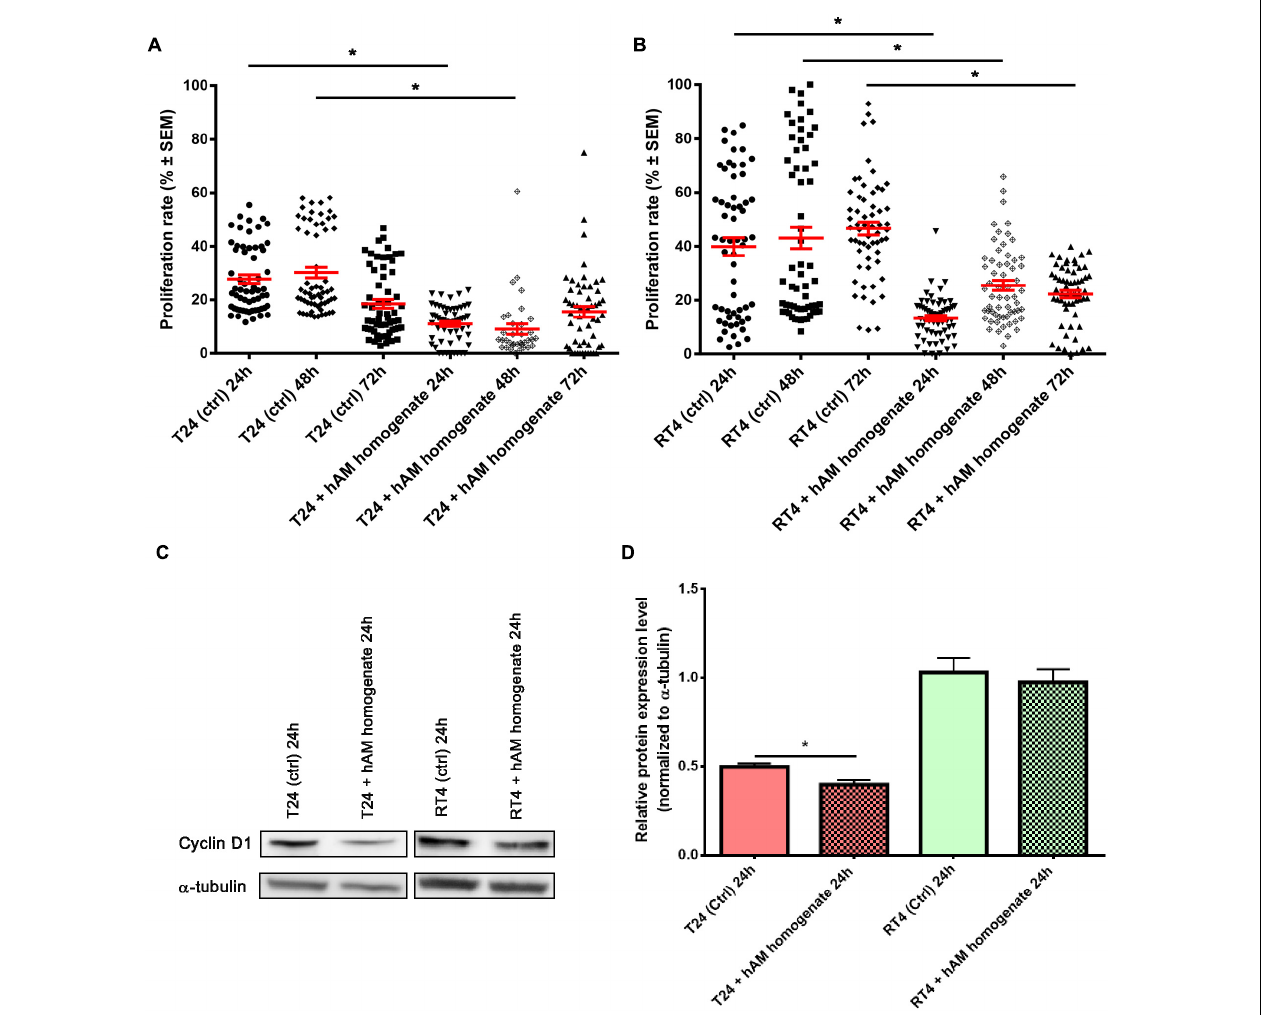
FIGURE 5 | Human amniotic membrane (hAM) homogenate decreases proliferation of T24 and RT4 cells and downregulates the expression of cyclin D1 in T24 cells. (A) The proliferation of T24 cells was decreased after 24, 48, and 72 h of treatment with hAM homogenate. (B) The proliferation of RT4 cells was decreased after 24, 48, and 72 h of treatment with hAM homogenate. (C,D) Western blot analysis of cyclin D1 and α -tubulin expression in T24 and RT4 cells treated with culture medium (ctrl) or hAM homogenate. The western blot analysis showed significant decrease in the expression levels of cyclin D1 after 24-h treatment with hAM homogenate in T24 cells. In RT4 cells, on the other hand, hAM homogenate induced slight but not significant decrease of cyclin D1 expression. All data shown here were obtained from at least three independent replications of experiments using three biological samples of hAM; each experiment was performed in two technical repeats for each condition. Bars represent mean ± SEM. * p <